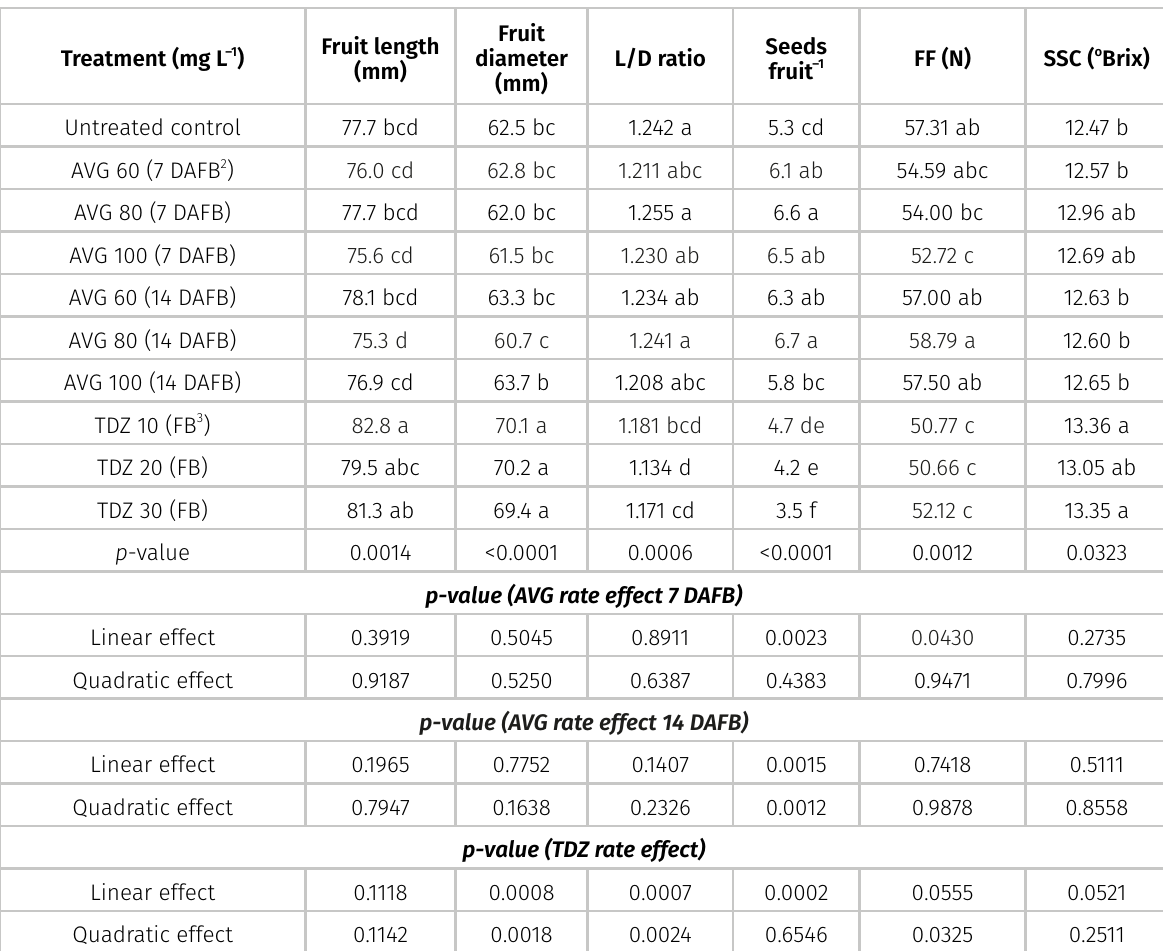
Table IV. Fruit length, fruit diameter, fruit length/diameter ratio, number of seeds per fruit, flesh firmness (FF) and solids soluble contents (SSC) of ‘Rocha’ pear trees subjected to aminoethoxyvinilglycine (AVG) and thidiazuron (TDZ) at different times in Antônio Prado, RS on 2016/2017 growing season.